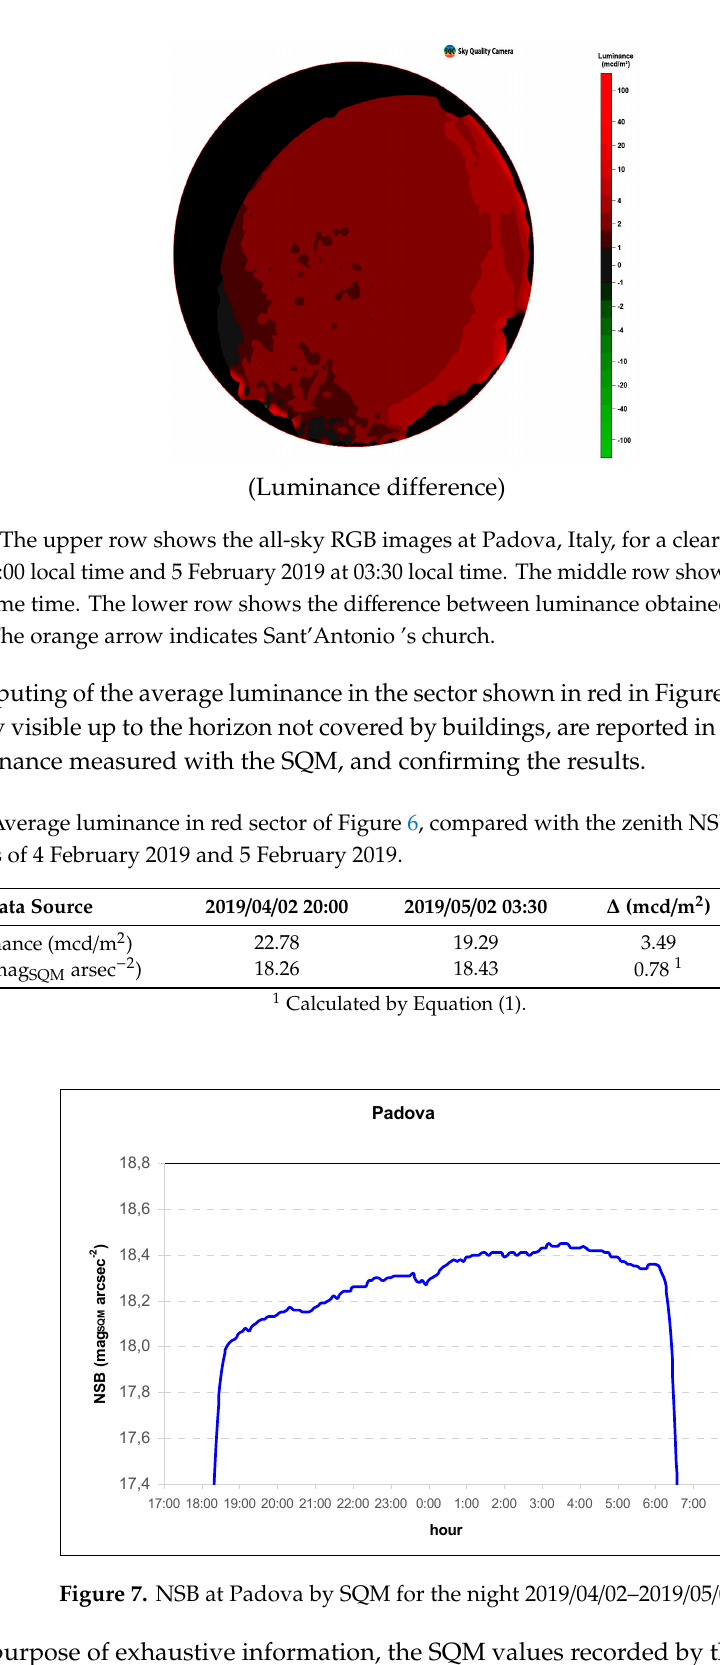
Table 5. Average luminance in red sector of Figure 6, compared with the zenith NSB from Figure 7 on the nights of 4 February 2019 and 5 February 2019.